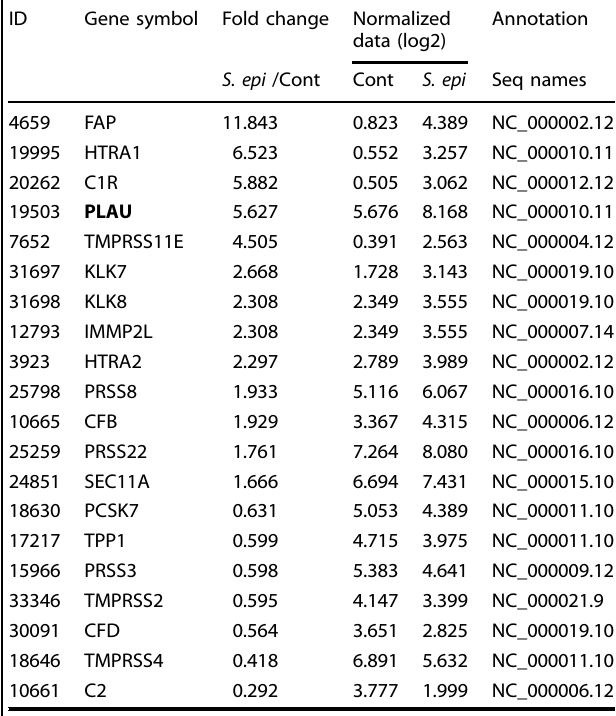
Table 2. Differential expression gene (DEG) linked with serine-type peptidase in S. epidermidis -inoculated NHNE